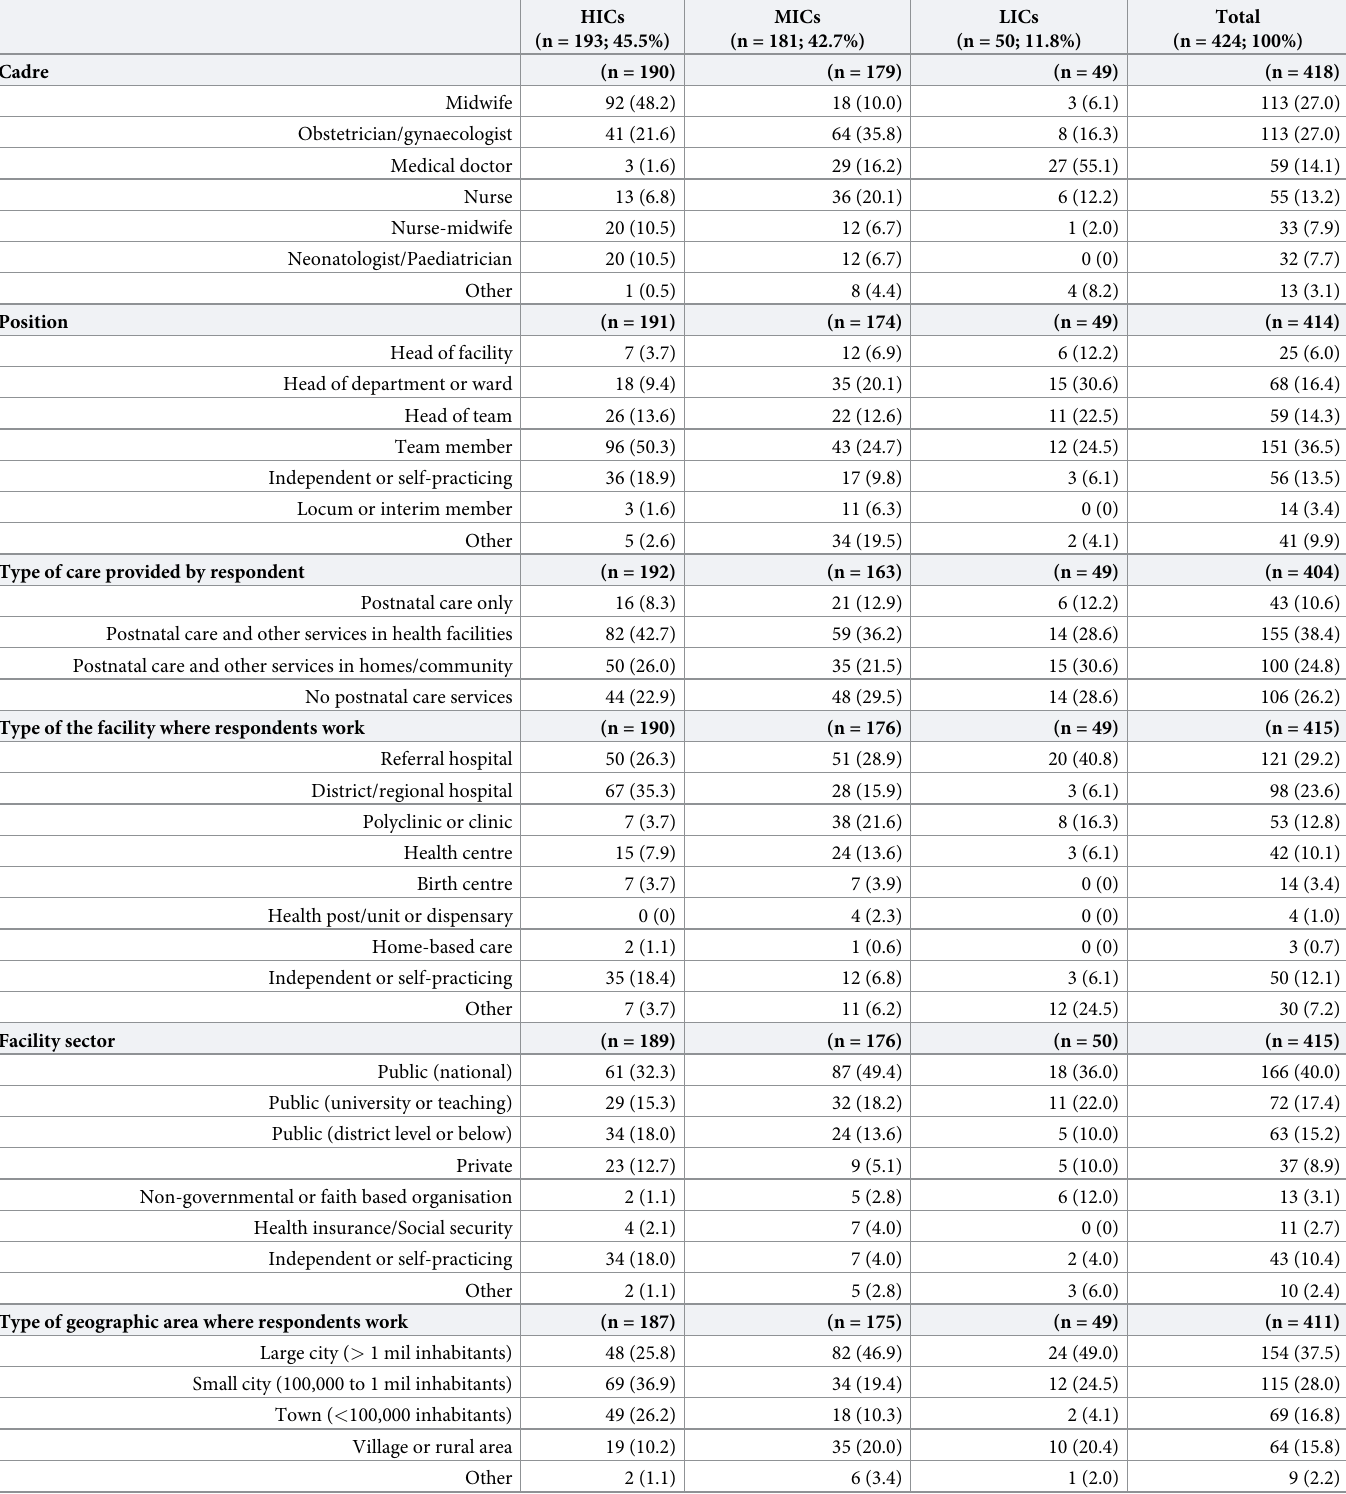
Table 1. Characteristics of the sample of maternal and newborn healthcare providers (n = 424) � , column